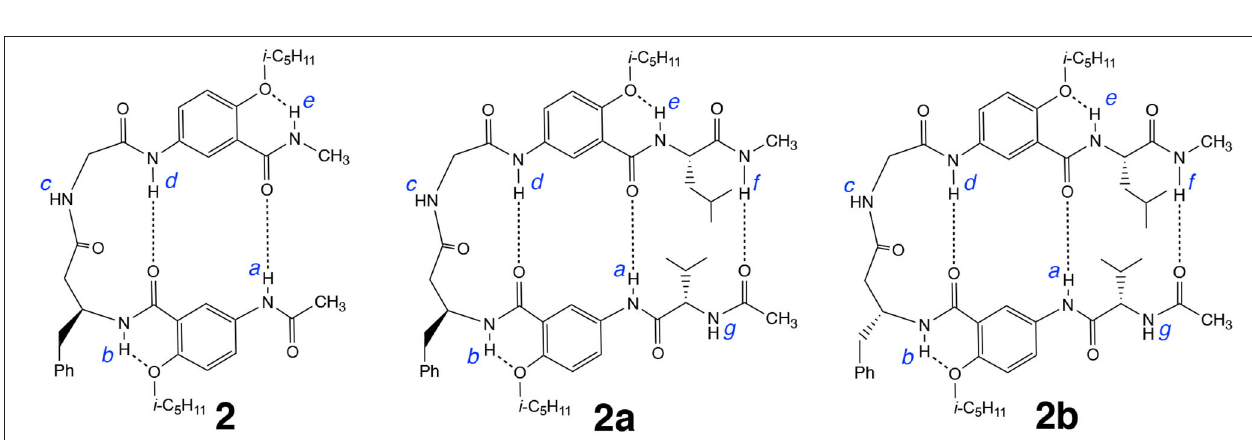
FIGURE 6 | Hexapeptide 2a , derived from tetrapeptide 2 , and hexapeptide 2b , derived from 2a , are expected to also adopt hairpin conformations.